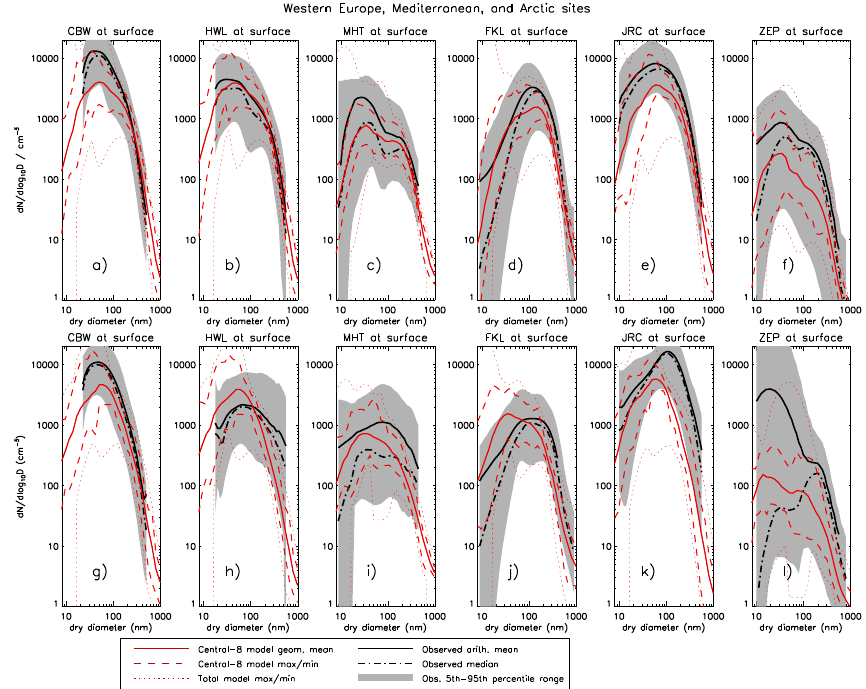
Figure 17. Summer (a–f) and winter (g–l) multi-model simulated size distributions against DMPS/SMPS measurements at the six EUSAAR sites classified as western Europe: Cabauw (CBW), Harwell (HWL), Mace Head (MHT), Mediterranean: Ispra (JRC), Finokalia (FKL) or Arctic: Zeppelin (ZEP). Shown are the central-8 model geometric means (red solid), central-8 model maximum/minimum (red dashed) and all-12 model minimum/maximum (red dotted) of the June–July–August (arithmetic) mean size distributions at each site. Observed values (black solid line) are arithmetic means over the hourly measurement data (A. Asmi, personal communication, 2012). The published (Asmi et al., 2011) median (black dot-dashed) and 5th to 95th percentile range (grey shading) over the hourly measurement data are also shown for